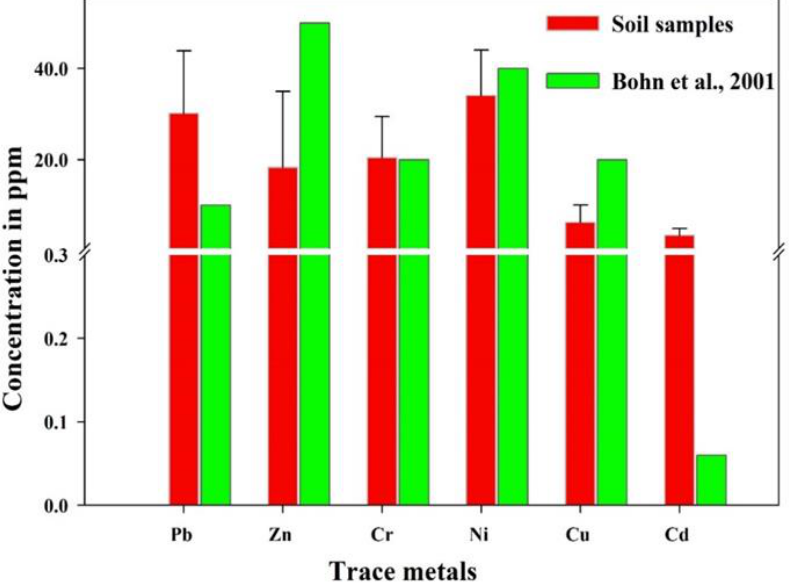
Figure 2. Comparison of mean values of trace element concentrations in the studied soil samples with those of Bohn et al. [31].